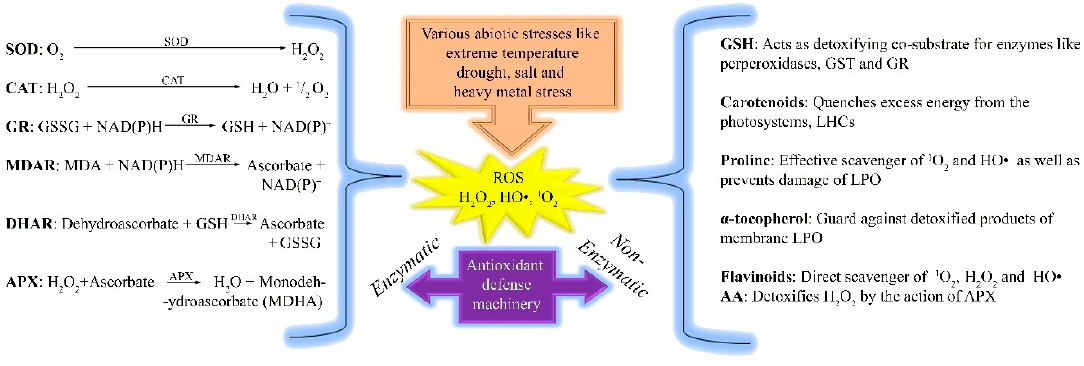
Figure 4. Anti-oxidant machinery scavenges cellular reactive oxygen species (ROS) through two pathways in plants. One is the enzymatic pathway and the other is a non-enzymatic pathway. Several enzymes convert ROS to non-harmful substances via enzymatic pathways in plant cells, while in the non-enzymatic pathway, other substances convert ROS to non-harmful substances.